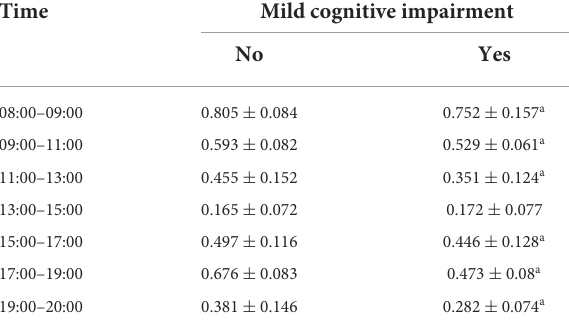
TABLE 5 Comparison of daytime activity between groups for each time